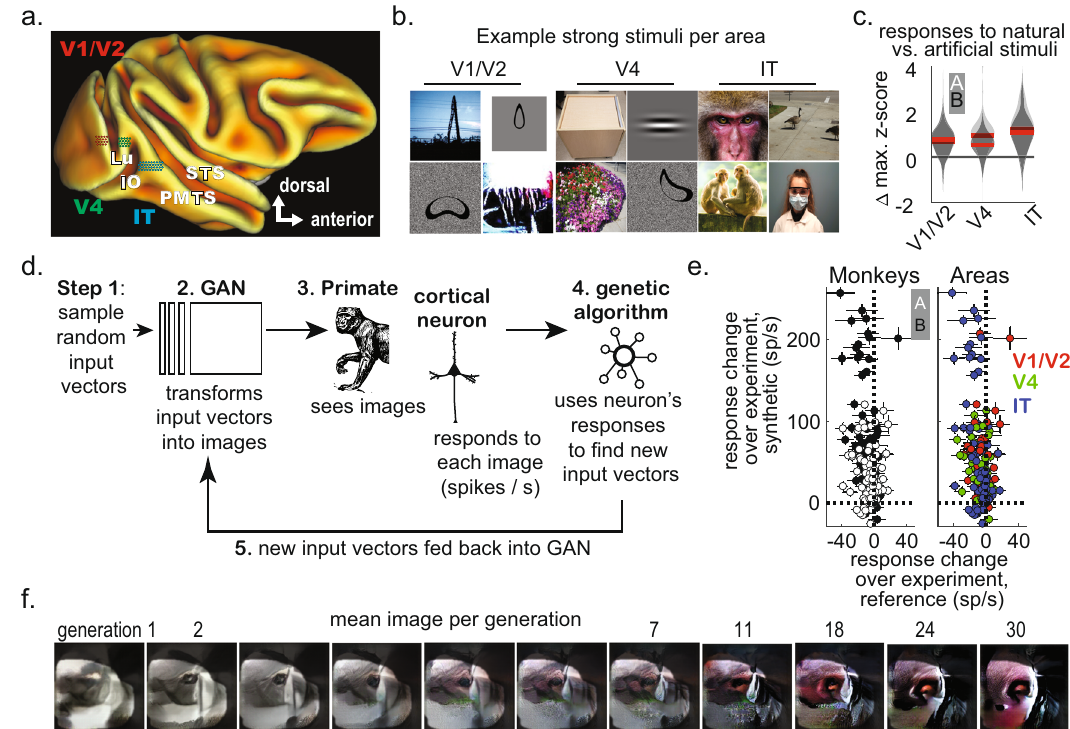
Fig. 1 Characteristics of the neuronal populations. a Sketch illustrating the location of fl oating microelectrode arrays relative to different occipito-temporal sulci (Lu: lunate, IO: inferior occipital, PMTS: posterior middle temporal, and STS: superior temporal), and their functional designation (V1/V2: red; V4: green; IT: blue). b Examples of images that elicited high responses from V1/V2, V4, and IT sites (some photographs are comparable replacements to the original stimuli, changed due to copyright issues, see our GitHub repository for originals 72 ). c Response difference between natural photographs and arti fi cial images for sites in different cortical areas per monkey (A, white; B, black, red line shows median). Neuronal spike rate responses were z-scored across images but within each site, then differences ( Δ ) measured from the z-scored responses shown as violin plots (red line = median values, n = array sites tested across days; monkey A, V1/V2, 150; V4, 67; PIT, 93; monkey B, V1/V2, 34; V4, 15; IT, 33). Each Δ value was obtained by subtracting the maximum z-score to arti fi cial images from the maximum z-score to natural images. d Experimental work fl ow for image synthesis, showing one full cycle of image generation. e Difference in mean neuronal response from the beginning to the end of the experimental session (events per second; mean ± SE); the y-axis shows the difference in mean response to the synthetic images over generations, and the x-axis shows the difference in mean response to the reference images over generations (because the reference images were not changing, the neurons showed adaptation during the experimental session). The left scatterplot shows results per monkey, and the right, for the cortical area (same colors as in panel a). n = experiments per animal, 127 in monkey A; 125 experiments in B. f One example image synthesis experiment using responses from a posterior IT site in Monkey B; each image corresponds to the average genotype of a given generation (black number on top). Mask shows the approximate location of the receptive fi eld center. Source data are provided as a Source Data fi le. Depicted individuals have consented for publication, and have seen these photos in the context of the publication.